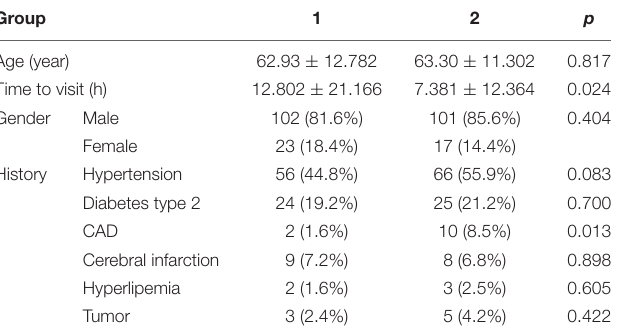
FIGURE 3 | A comparison of time points between the groups. (The vertical axis is in minutes).